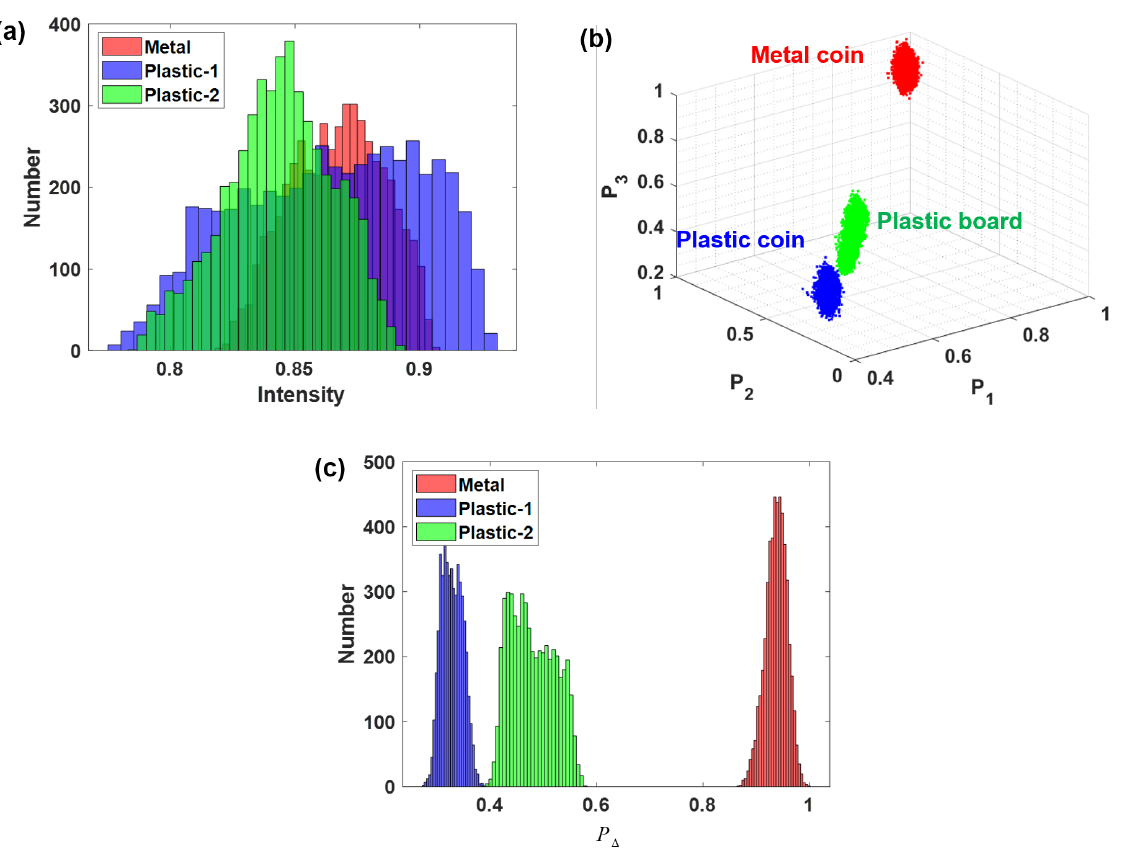
Figure 6. Comparison for three regions in terms of ( a ) intensity histograms, ( b ) IPPs, and ( c ) P ∆ .